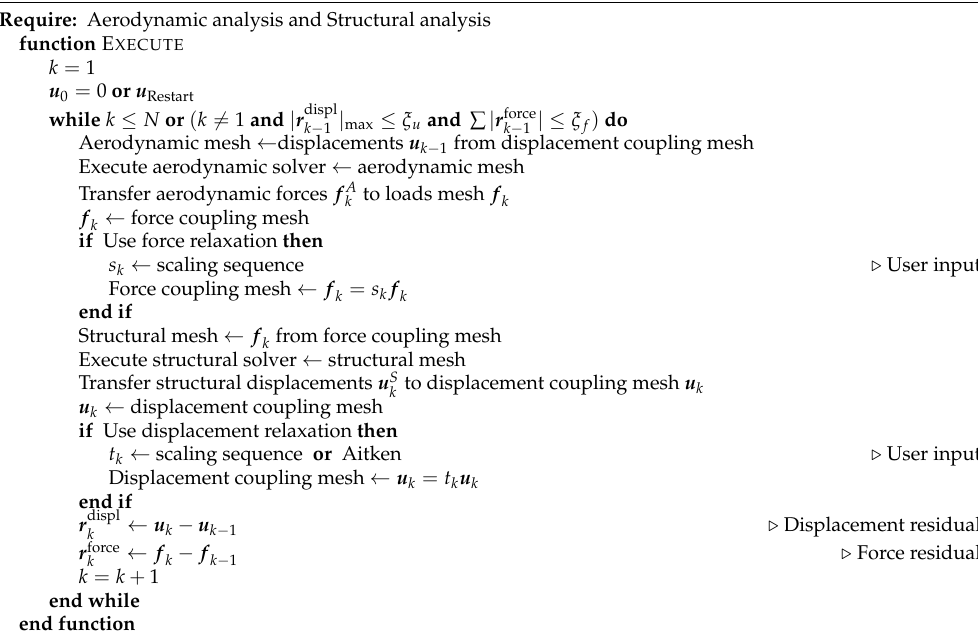
Algorithm 2 The steady aero-structural